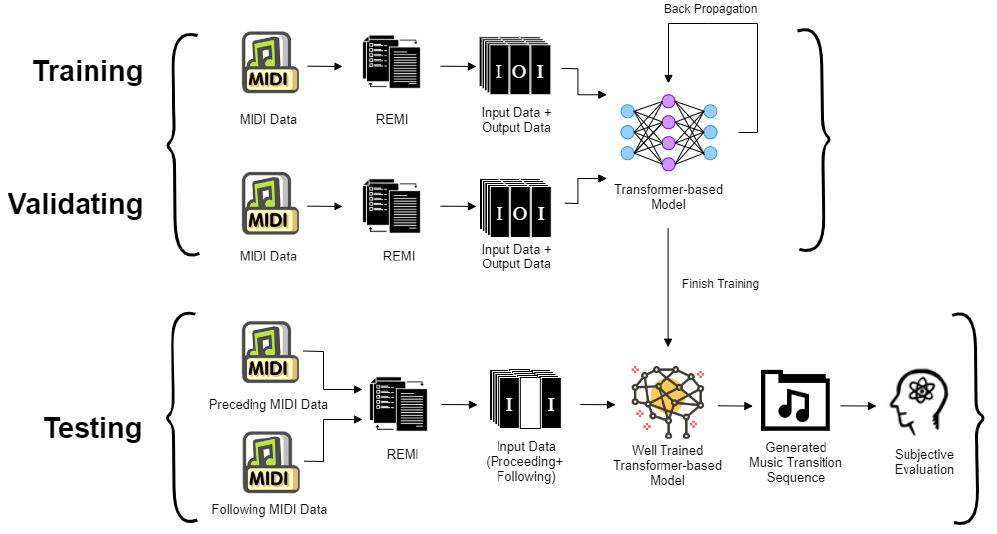
Figure 7. The proposed